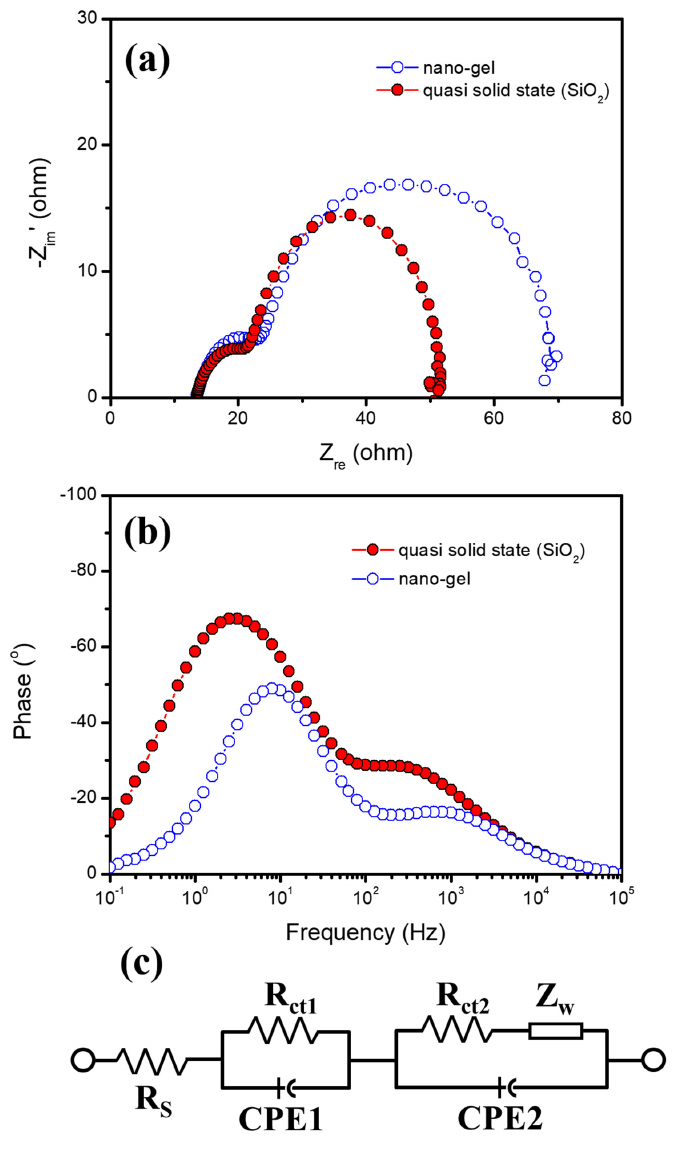
Figure 3. ( a ) Nyquist and ( b ) Bode phase plots of EIS spectra of DSSCs based on nanogel and quasi- solid-state (SiO 2 ) electrolytes and ( c ) equivalent circuit of DSSCs.